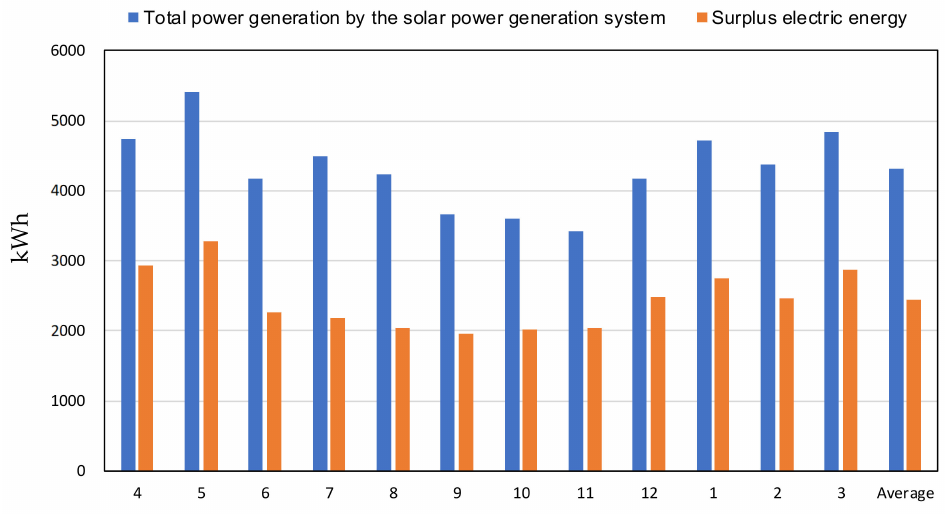
Figure 8. The monthly average and average surplus power generated by the solar power system. in the building during